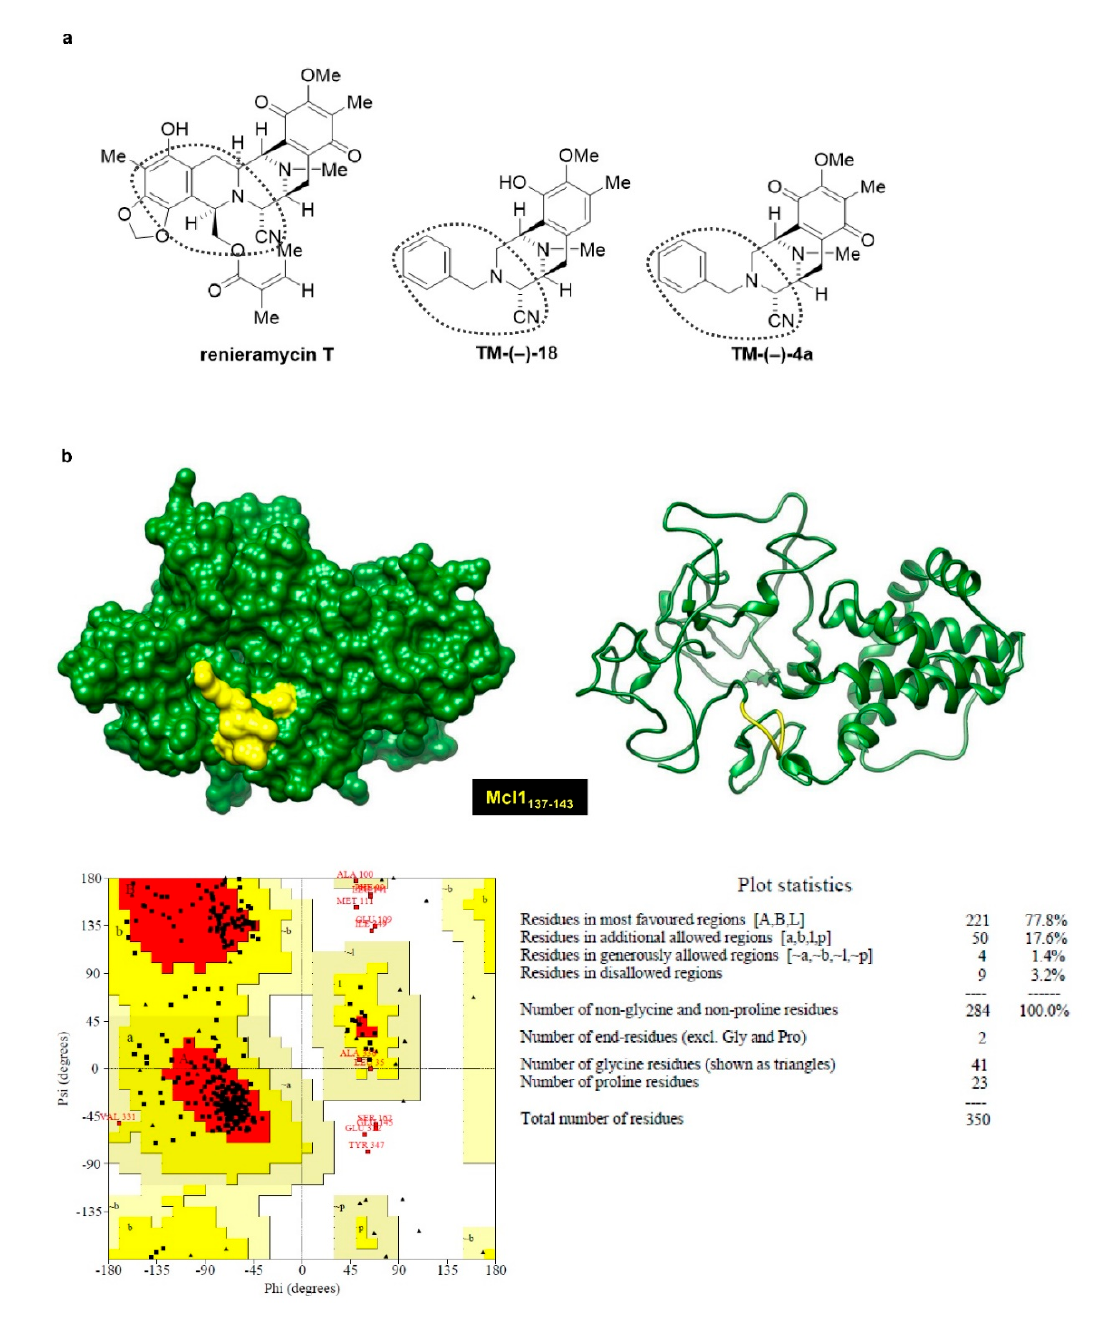
Figure 5. ( a ) Structures of RT, TM-(–)-18, and TM-(–)-4a. Circled part represents a similar structure between these three compounds. ( b ) Stereochemical quality of the homology model of Mcl-1 created by the I-TASSER server. Ramachandran plot of Mcl-1 generated by PROCHECK. Areas colored by red, yellow, beige, and white indicate the most favored, additionally allowed, generously allowed, and disallowed regions, respectively.